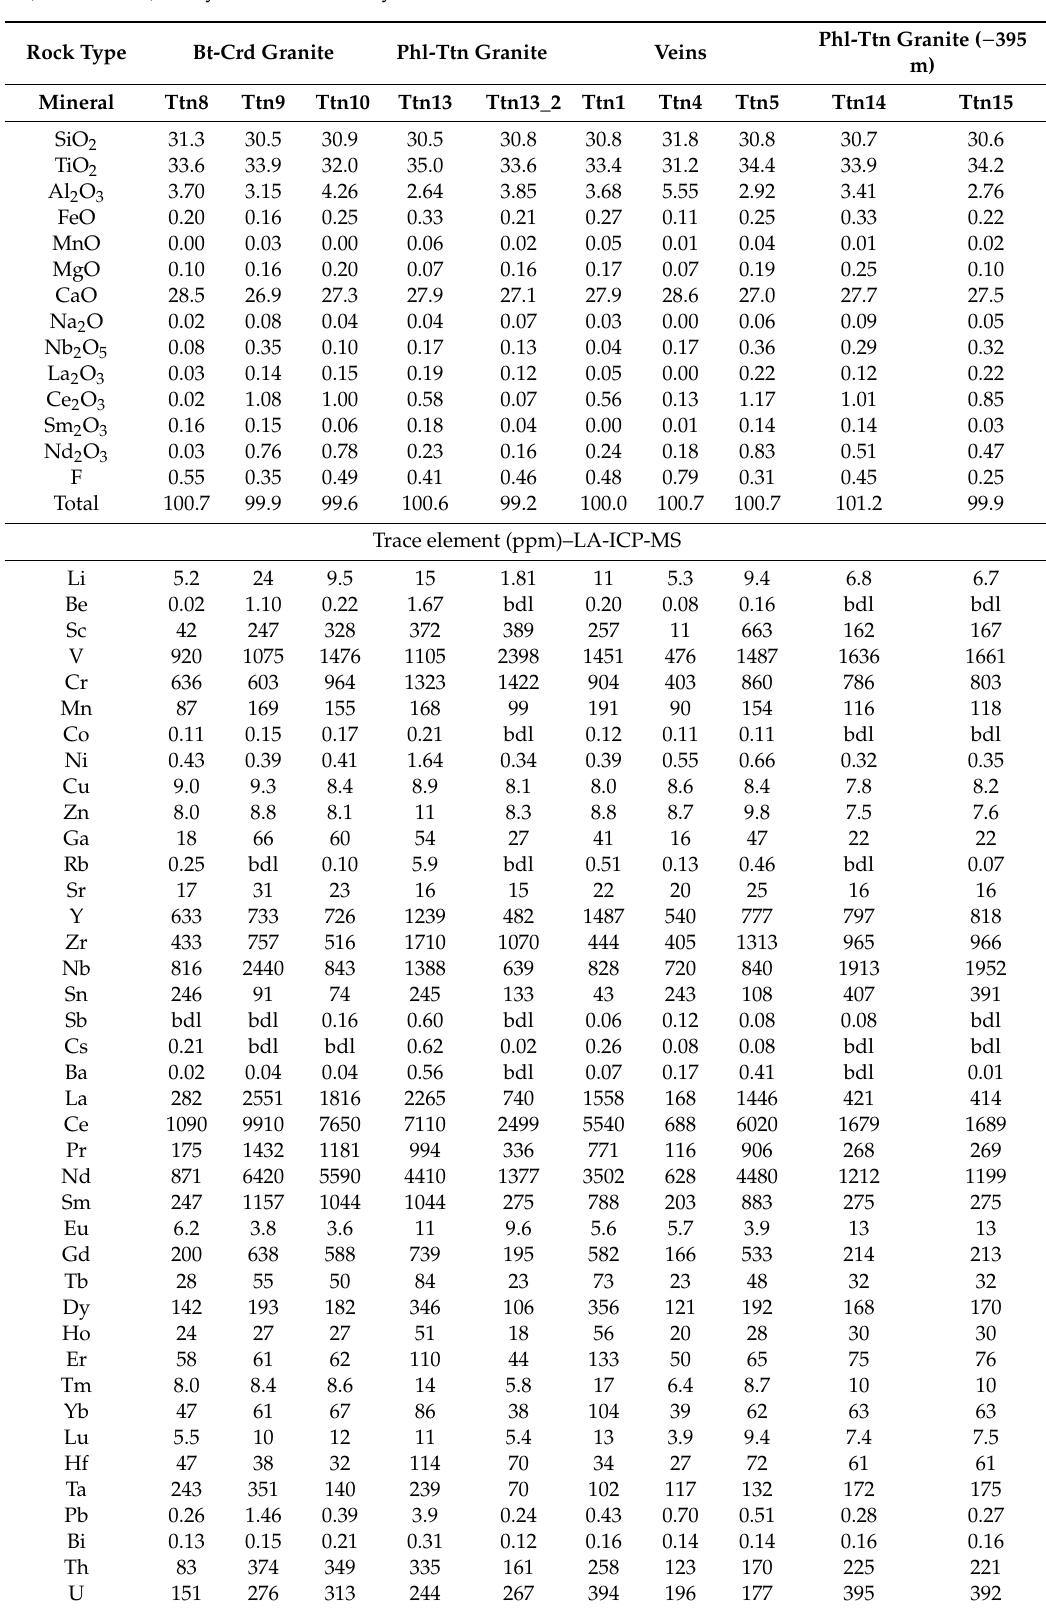
Table 3. Selected electron microprobe and laser ablation inductively coupled plasma mass spectrometry (LA-ICP-MS) analyses for titanite crystals from the BM